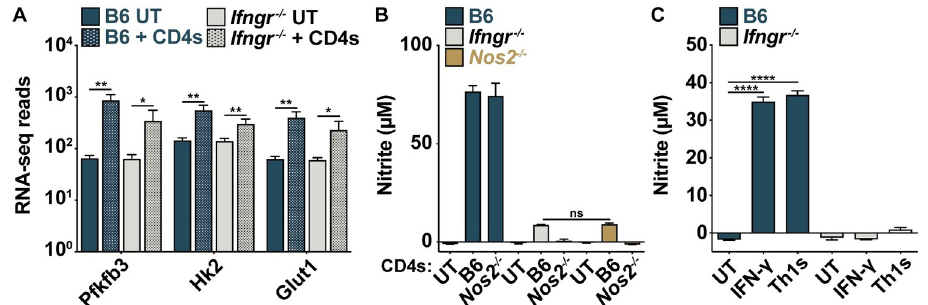
Fig 3. CD4 T cells induce IFN- γ - and NO-independent increases in glycolytic gene expression. ( A ) RNA-seq reads of glycolytic genes. ( B ) Griess assay at 48 h postinfection for wild-type, Ifngr -/- , and Nos2 -/- BMDMs co-cultured with a 10:1 ratio of wild-type or Nos2 -/- lung-derived CD4 T cells to macrophages. ( C ) Griess assay at 48 h postinfection for wild-type and Ifngr -/- BMDMs co-cultured with Th1 cells. Figures represent data from four replicate experiments (A) or are representative of two (B) or three (C) independent experiments. Error bars are SD from four independent experiments (A) or four replicate samples (B)-(C), � p < 0.05, �� p < 0.01, ���� p < 0.0001 by unpaired t-test.